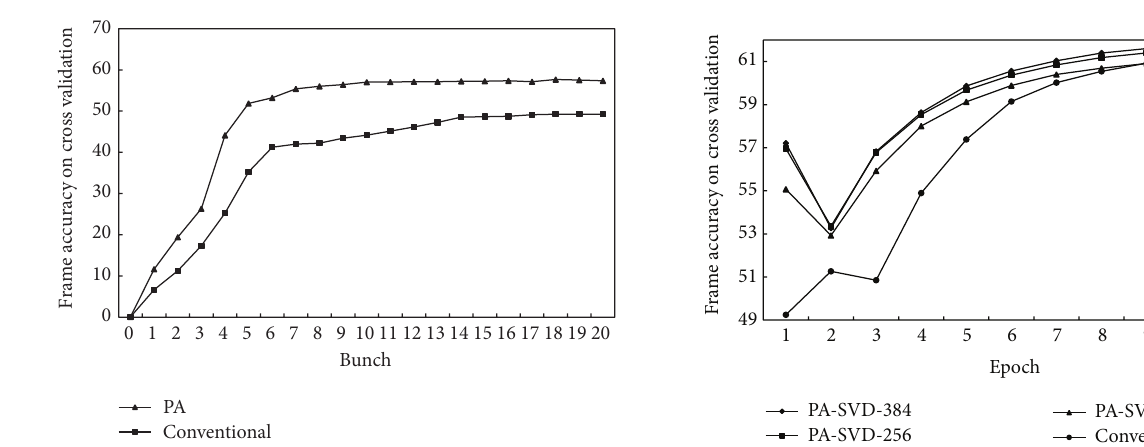
Figure 4: Changes of cross entropy losses.